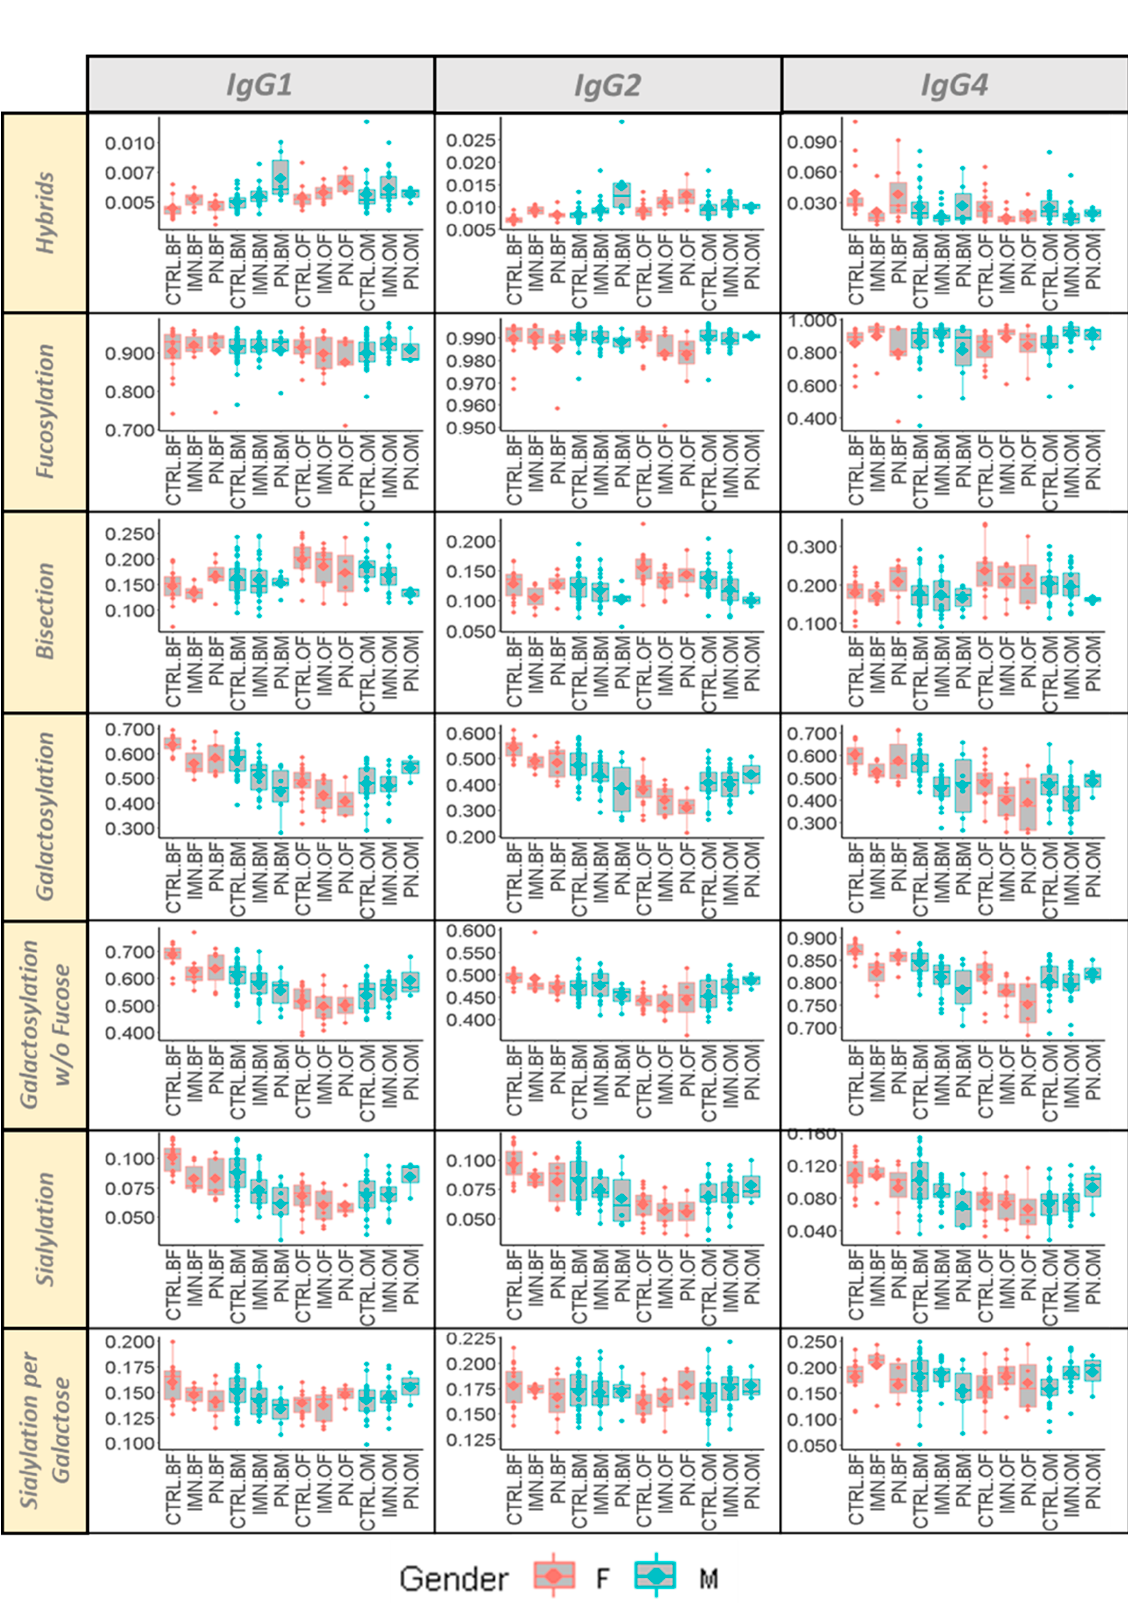
Figure 2. Box plots of seven glycosylation traits of IgG1, IgG2, and IgG4 stratified according to sex (F = female, M = males) and age (O = over 60 years old—age ≥ 60; B = below 60 years old—age < 60) for all the groups of the cohort (IMN = Idiopathic Membranous Nephropathy; CTRL = healthy controls; PN = pathological controls with non-IMN nephropathy).